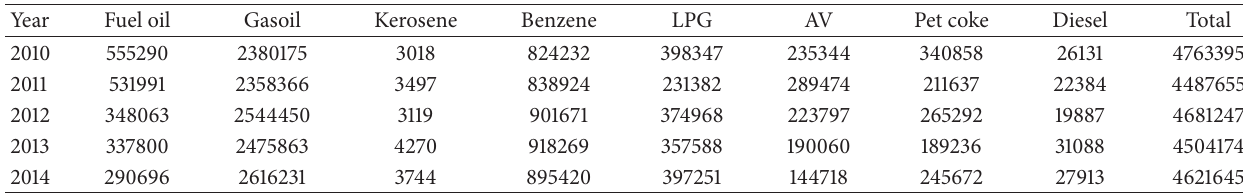
Table 14: Sudan fuel demand/consumption (ton) [6].